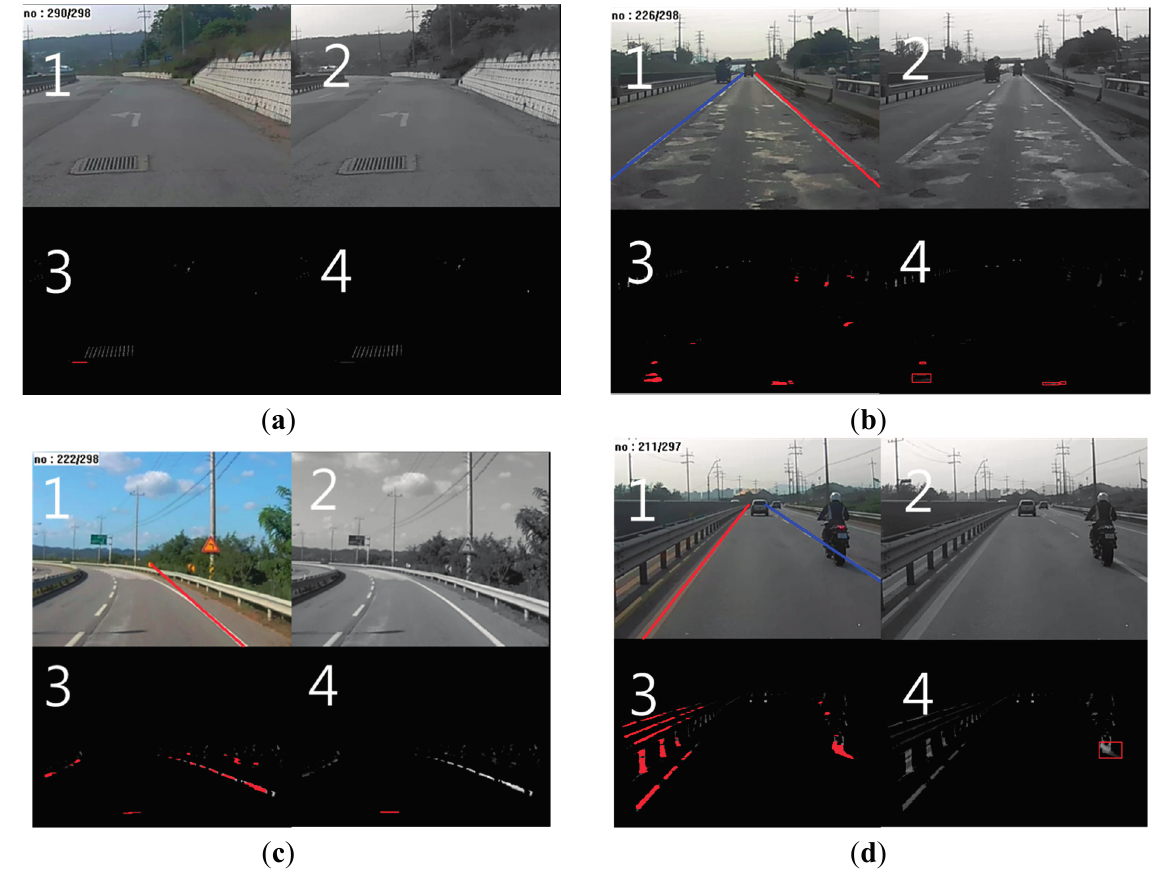
Figure 14. Similar object removal: ( a ) manhole; ( b ) patchy surface; ( c ) shaded regions; ( d ) moving